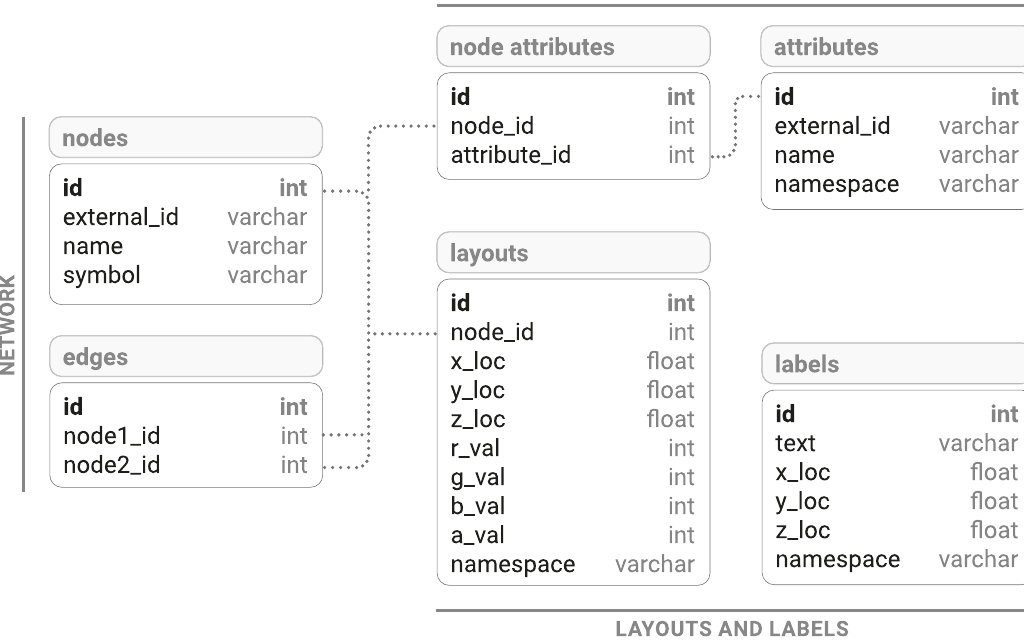
Fig. 6 Database schema. All data are stored in a MySQL database. The user can upload their own networks using the web module to create and populate the tables